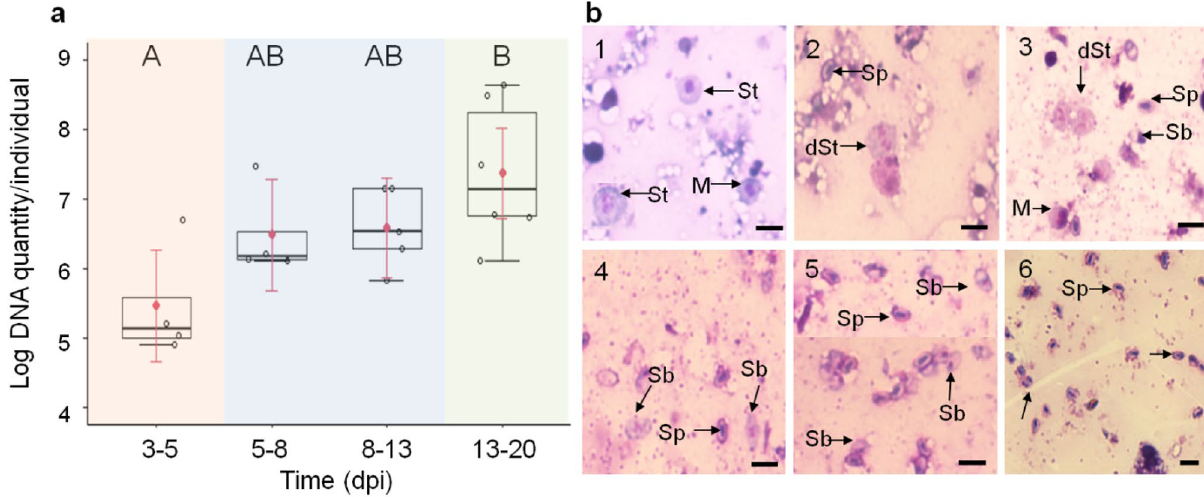
Figure 2. ( a ) Copy numbers of small subunit ribosomal DNA (SSU rDNA) (mean = red dot) of T. suzukii in single D. suzukii (SWD) larvae (orange), pupae (blue) and adults (green). The course of infection for second instar larvae (L2) inoculated with 4 × 10 4 spores. Replicates/numbers (R/N): larvae 3–5: R/N = 2/4, pupae 5–8: R/N = 2/4, pupae 8–13: R/N = 3/5, adult 13–20: R/N = 3/6. GLM analysis for gamma distribution with log- link: χ 2 = 14.014, DF = 3, P = 0.003, Tukey test: 3–5 and 13–20: P < 0.001, 5–8 and 13–20: P = 0.252, 8–13 and 13–20: P = 0.305. Different letters indicate statistical difference. Boxplot indicates the median logarithmic DNA quantity per individual (horizontal bar), mean (red dot), error bars (black hinge), asymptotic upper and lower confidence limits (red hinge) outliers (white dot). ( b ) Bright-field light microscopy of Giemsa-stained smears. Developmental stages of T. suzukii isolated from SWD larvae, pupae and adults at different time points post inoculation. SWD were inoculated in L2 larval stage with 4 × 10 4 T . suzukii spores. (1) Larval stage (6 dpi). (2) Early pupal stage (8 dpi). (3) Pupal stages (10 dpi). (4) Late pupal stage (13 dpi). (5) Early adult stage (15 dpi). (6) Adult stage (17 dpi). Abbreviations: (M) meront containing two nuclei, (St) sporont, (Sp) spore, (dSt) dividing sporont, (Sb) sporoblast. Scale bar = 5 binomial model with over-dispersion: F = 8.91, DF = 3, P (F) < 0.001, Tukey test: Control—5 × 10 2 : P = 0.889, Con- trol—5 × 10 3 : P = 0.226, Control—5 × 10 4 : P < 0.0001), (Fig. 3a).